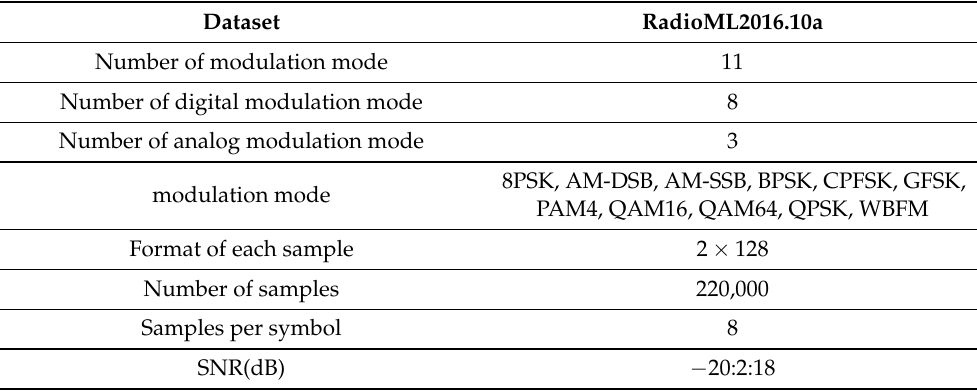
Table 7. Description of display parameters for Radio2016.10a dataset.